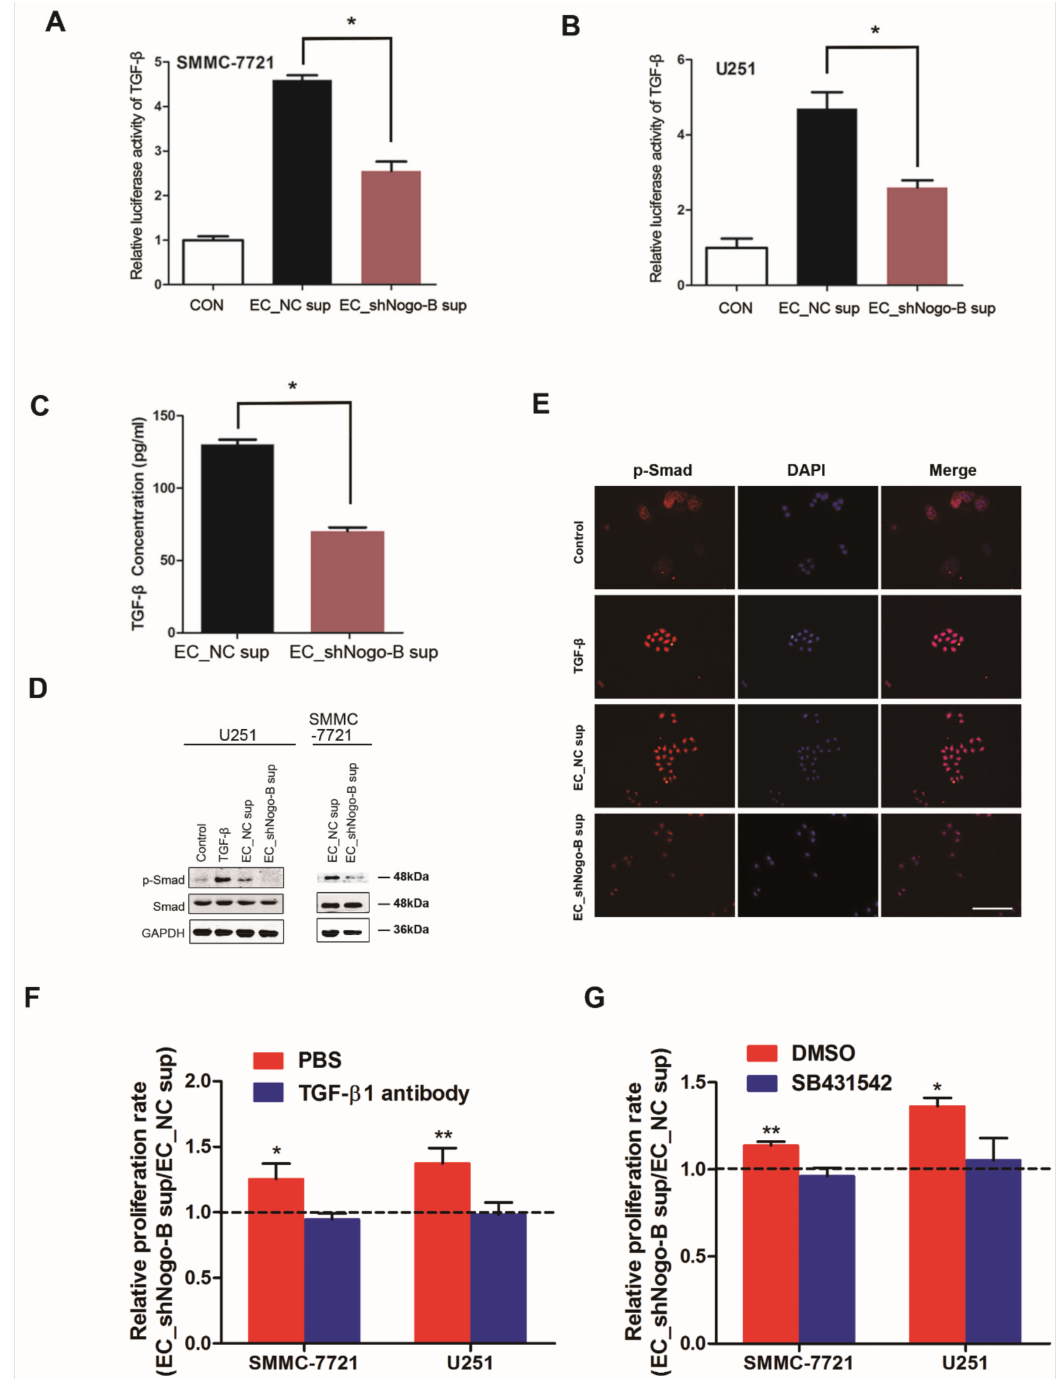
Figure 5. Endothelial Nogo-B suppresses cancer cell proliferation by promoting TGF- β